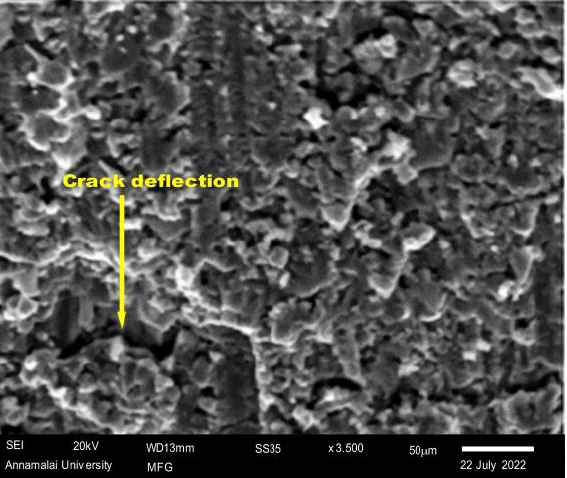
Figure 12. Scanning electron micrographs of indentation cracks in TiB 2 -30Si 3 N 4 -6B 4 N. The inclusion of B 4 N and Si 3 N 4 changes the fracture mode from intergranular to mostly transgranular (as seen from the broken surface in Figure 13). When the toughening process is integrated into the fracturing mechanism, the material has sufficient energy to reduce the propagation of cracks.